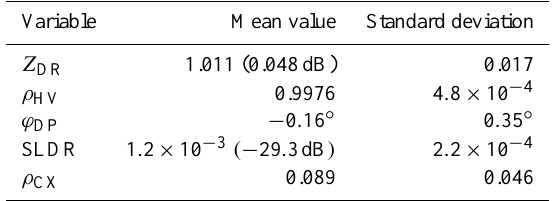
Table 2. Polarimetric variables calculated without the correction for the antenna coupling. Values are based on measurements with the vertically pointed cloud radar in light rain on the 1 May 2014. The statistics are based on the height range from 500 to 1700m and the time period from 17:55 to